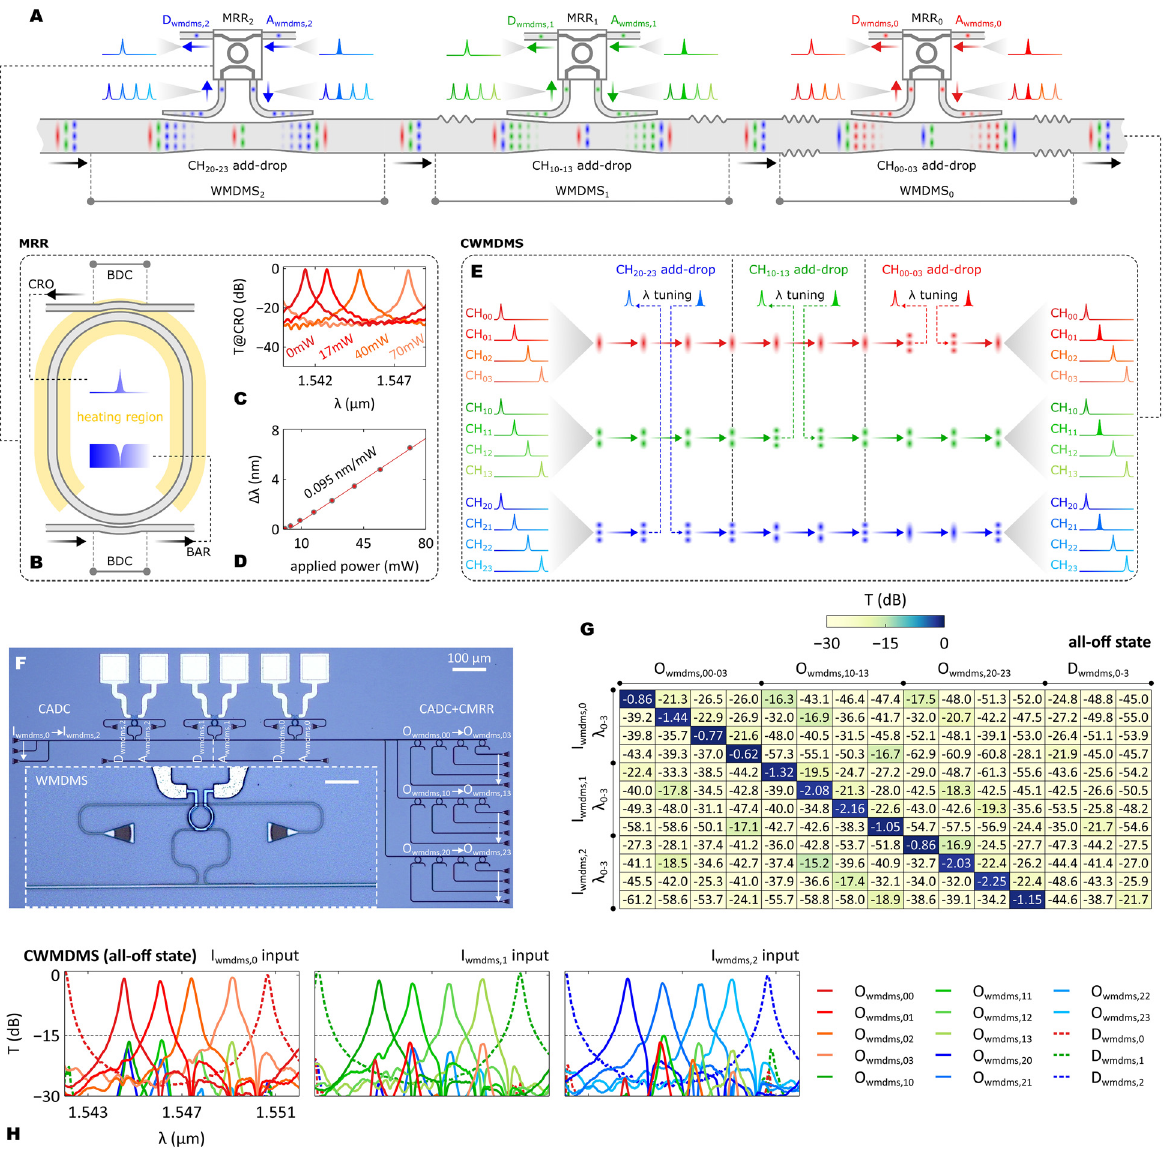
Figure 7: Design and all-off measurement results for direct-access wavelength/mode-division multiplexing switches (WMDMSs). (A) The schematic configuration of cascaded WMDMSs (CWMDMS). (B) The schematic configuration of tunable micro-ring resonator (MRR). (C) The measured transmittance spectra at the CRO port of MRR as applied electrical power is varied. (D) The measured tuning ef fi ciency of MRR.(E)Theillustrationofwavelength/modeadd-dropoperations.(F)Theopticalmicroscopeimageoffabricateddeviceswithportidenti fi ers labeled. The inset shows the enlarged view of a single WMDMS. (G) The measured transmittance matrix for CWMDMS at all-off state. (H) The measured transmittance spectra for CWMDMS at all-off state as light is launched from input ports. BDC, bent directional coupler; CADC, cascaded asymmetric directional coupler; CMRR, cascaded micro-ring